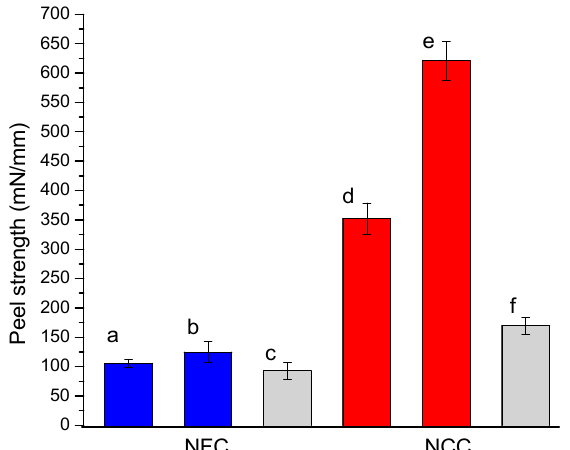
Figure 12. Peel strength for cotton textiles adhered with ( a , b ) NFC and ( d , e ) NCC with ( a , d ) no cross-linking and ( b , e ) with covalent cross-linking using MA compared with ( c ) NFC and ( f ) NCC adhered cellophane films.